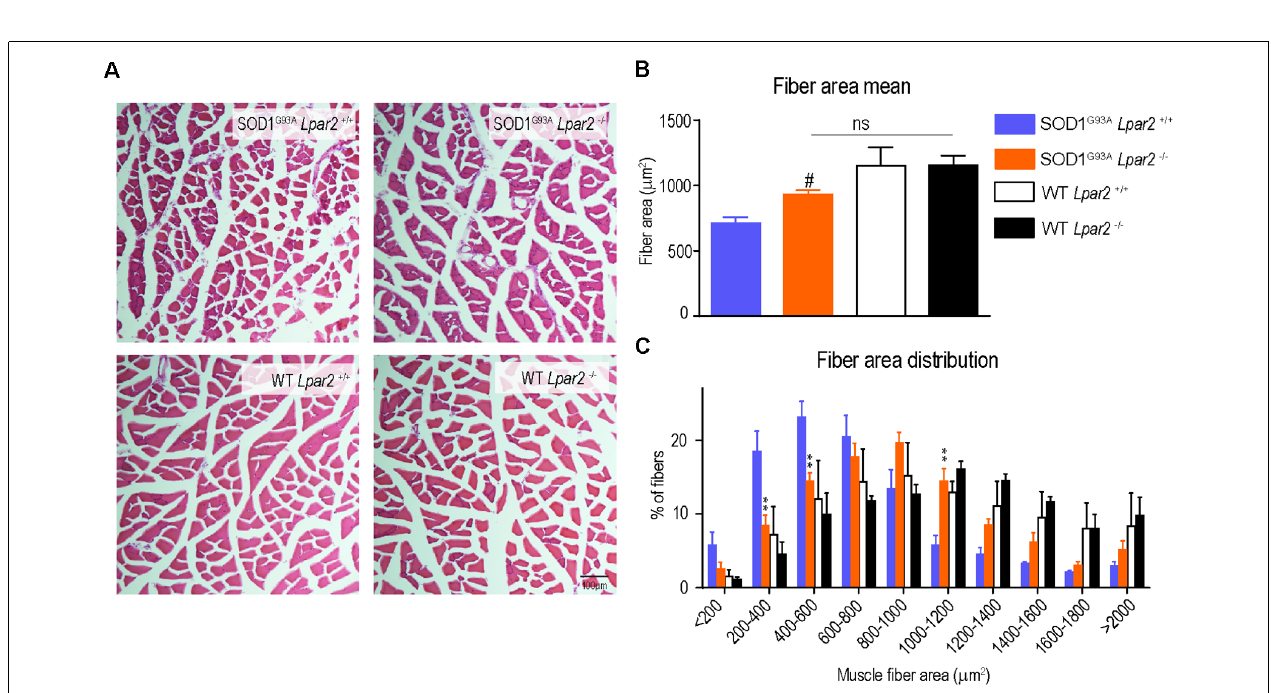
FIGURE 7 | Lpar2 gene deletion prevents muscle atrophy in SOD1 G93A mice. (A) Representative images of gastrocnemius muscle stained in hematoxylin and eosin at 16 weeks of age in male mice. (B) Quantification of the muscle cross-section area at 16 weeks of age in male mice. (C) Plot showing the distribution of muscle fiber width (males; n = 4 per group). One-way ANOVA, Bonferroni’s post hoc test. # p < 0.05 vs. WT Lpar2 +/+ ; ns, not significant vs. WT Lpar2 -/- in (B) ; Two-way ANOVA, Bonferroni’s post hoc test in (C) . ** p < 0.01 vs. SOD1 G93A Lpar2 +/+ . Data are presented as mean ±